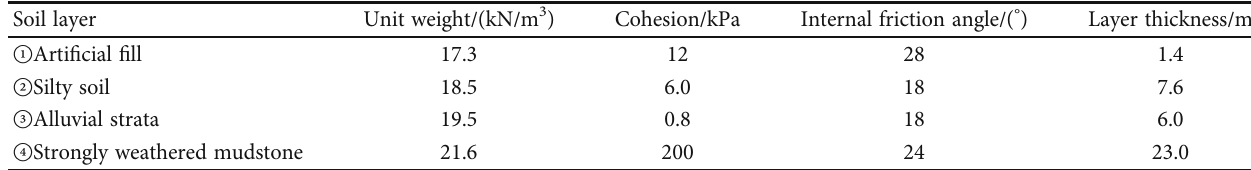
Figure 7: Change rules of di ff erent parts supporting pressure with the buried depth h considering the e ff ect of soil heterogeneity and pore water: (a) φ = 16 ° , c 0 = 15kPa ; (b) φ = 18 ° , c 0 = 10kPa ; and (c) φ = 20 ° , c 0 = 5 kPa . Table 3: Stratum